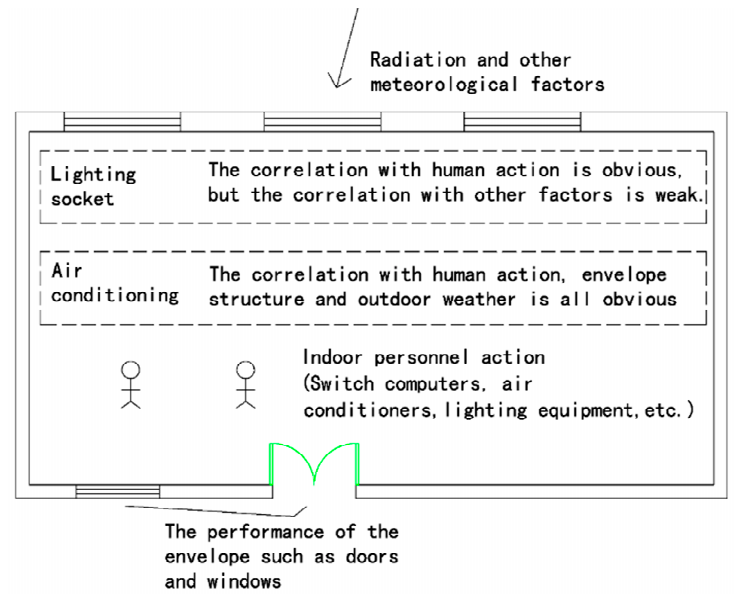
Figure 1. The indoor energy consumption component and its influencing factors in public buildings.